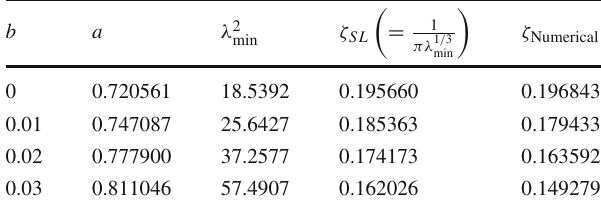
Table2 Comparisonofanalyticalandnumericalvaluesof ζ = T c /ρ 1 / 3 for α = 0 . 01